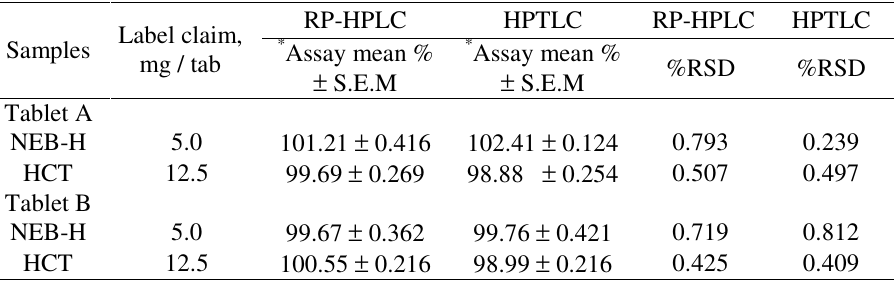
Table 2. Analysis of formulation by RP-HPLC &